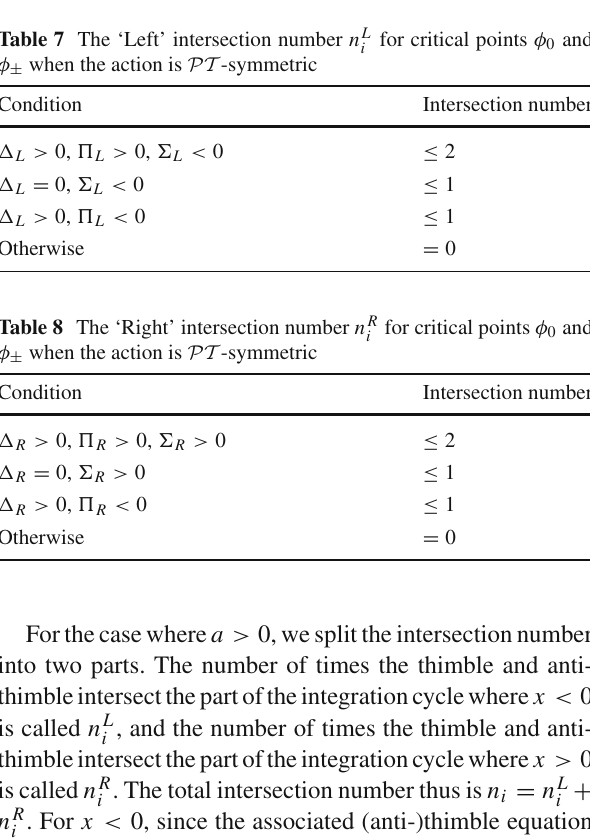
Table 7 The ‘Left’ intersection number n L φ ± when the action is PT -symmetric Condition